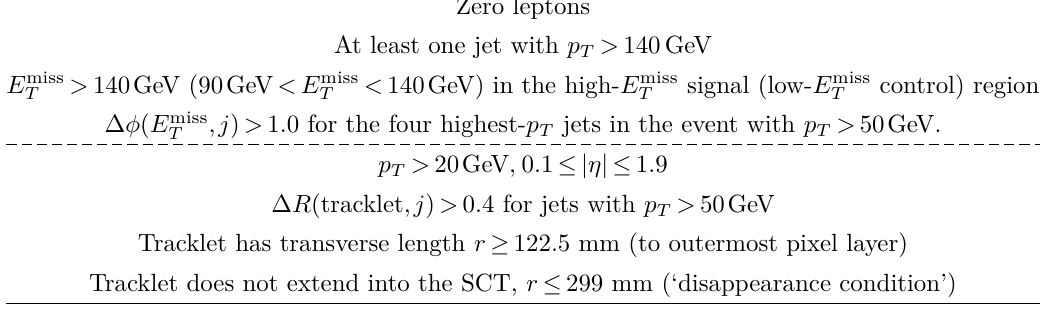
Table 1 . Event selection (above the dashed line) and tracklet selection (below the dashed line) cri- teria used in our validation. The tracklet selection criteria are applied to generator-level